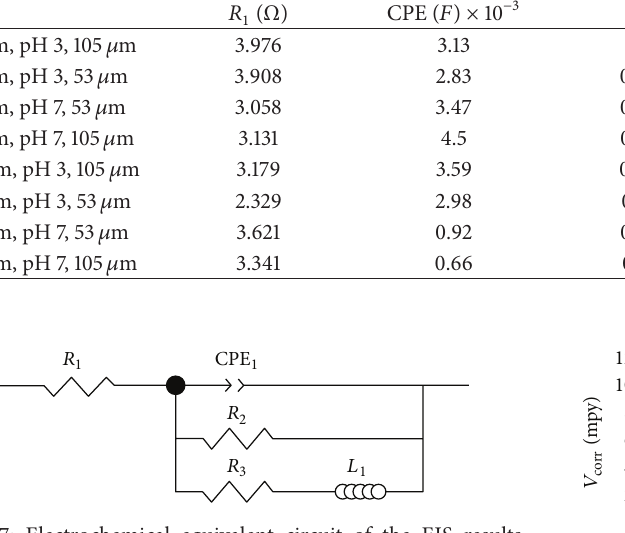
Figure 7: Electrochemical equivalent circuit of the EIS results measured.